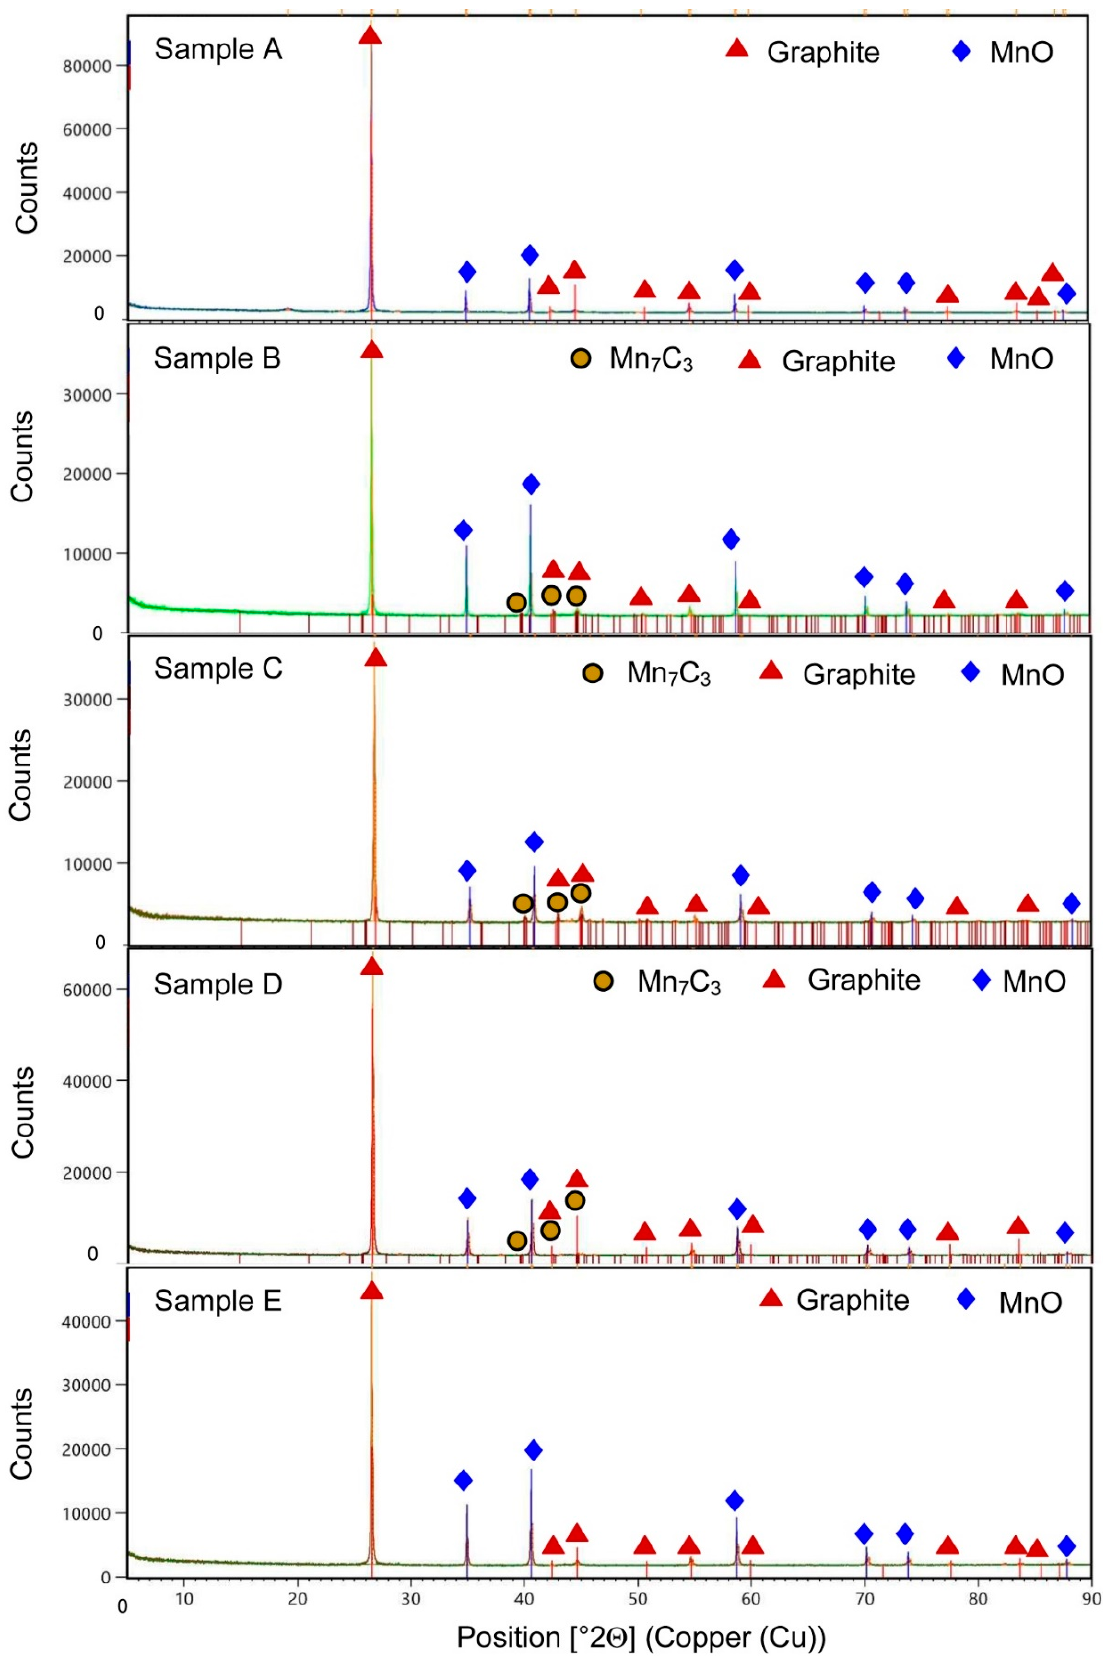
Figure 4. XRD patterns for samples A–E.